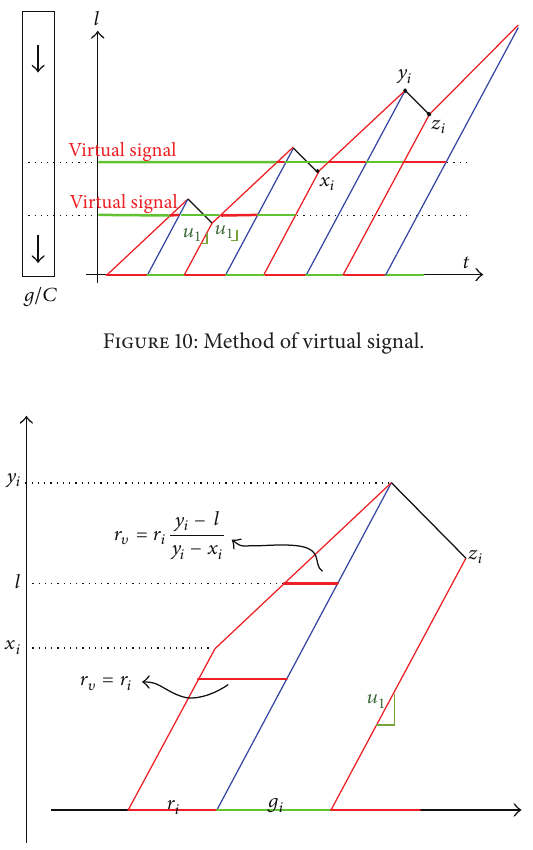
Figure 11: Virtual split